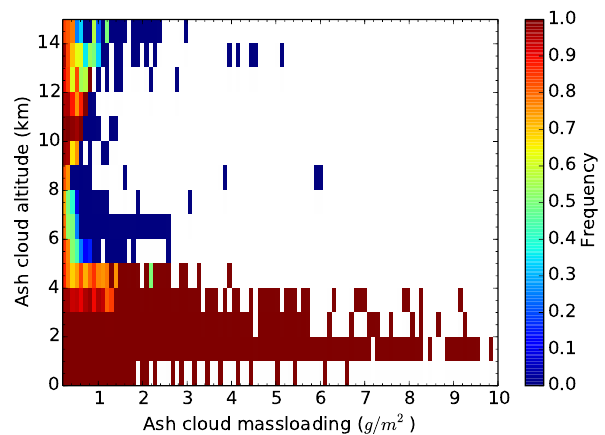
Figure 15. Similar to Fig. 10, but for the Grímsvötn (2011) erup- tion.